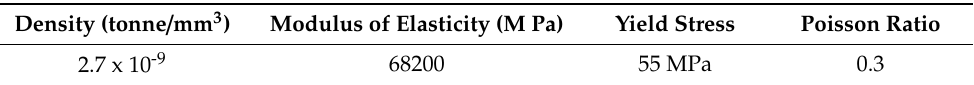
Table 2. Material properties of aluminum [43].